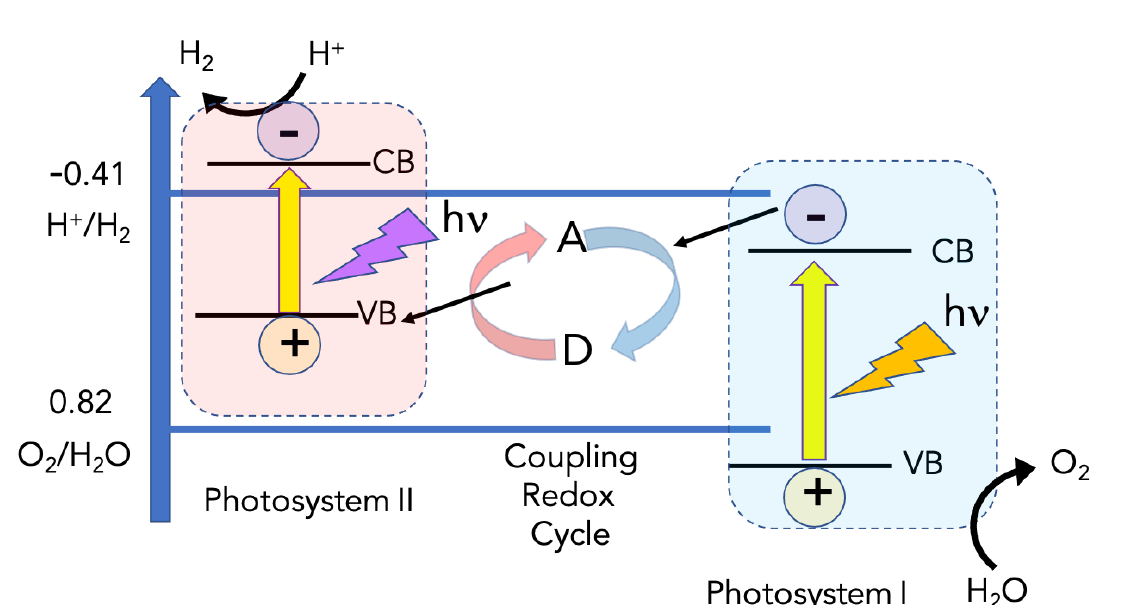
Figure 8. Example of water splitting reactions based on the Z-scheme that couples two photosystems through a common redox cycle. A = Acceptor species; D = Donor species. See the main text and [62,63] for details.